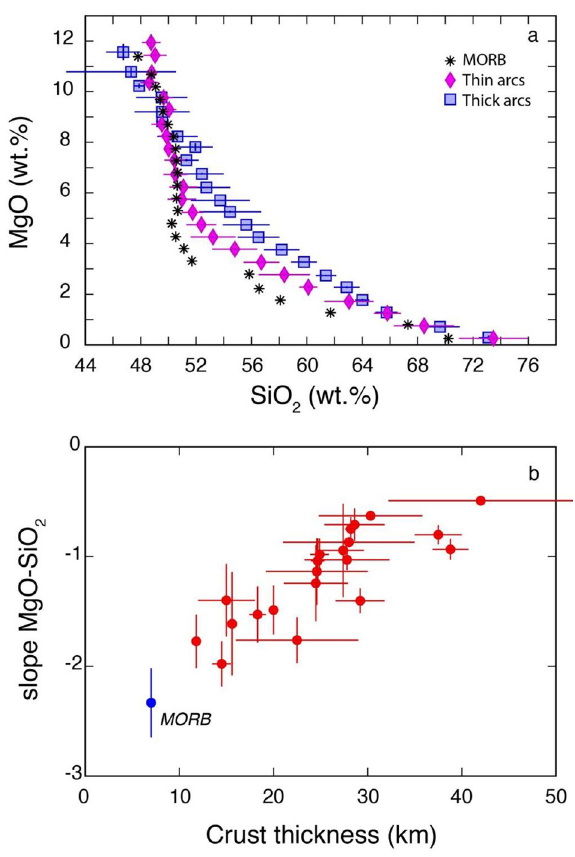
Figure 2. MgO-SiO 2 systematics of arc and MOR magmatic rocks. ( a ) MgO-SiO 2 plot of the averages of median values of all thin (< 20 km) and all thick (> 30 km) arcs compared to median values of MOR magmas for MgO bins ~ 0.5 wt% (data reported in Supplementary Data File 1); ( b ) plot of the MgO-SiO 2 slopes of the early evolutionary parts (MgO > 2–5 wt% depending on the arc) of individual arcs and MOR magmatic rocks versus crustal thickness (data reported in Table 1).